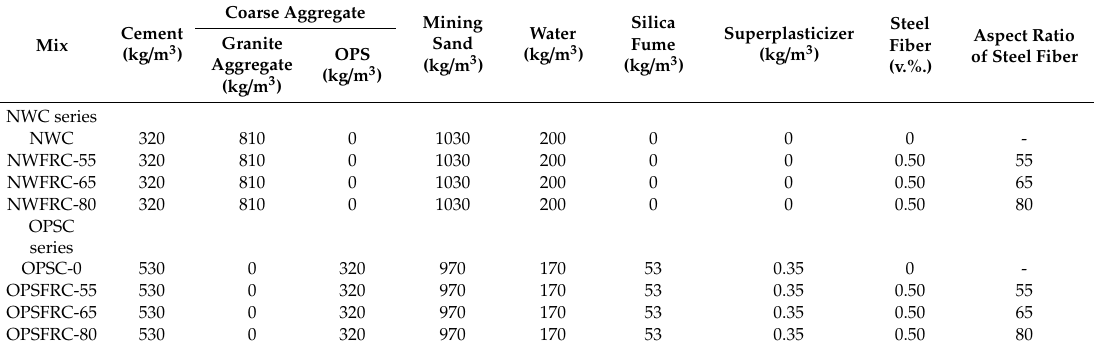
Table 2. Mix proportion of normal weight concrete (NWC) and LWAC prepared with OPSC [71], with copyright permission from Elsevier.